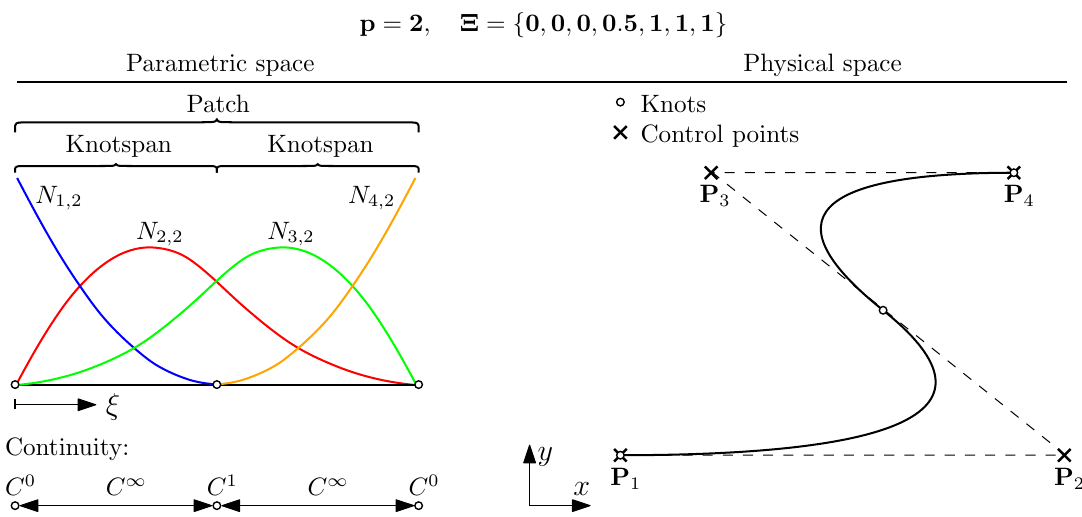
Figure 1. Description of B-spline (NURBS) finite element geometry. The geometry is modeled by one patch consisting of two knotspans with quadratic NURBS